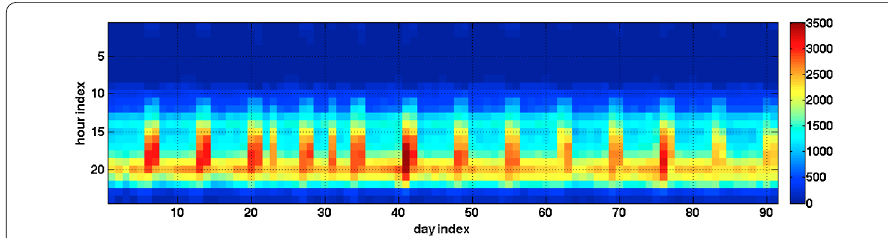
Figure 1 Visualization of the hourly number of transactions in the metropolitan area during the period the data set covers. The horizontal axis corresponds to the index of the days in the data set, and the vertical axis corresponds to the index of the specific hours of each